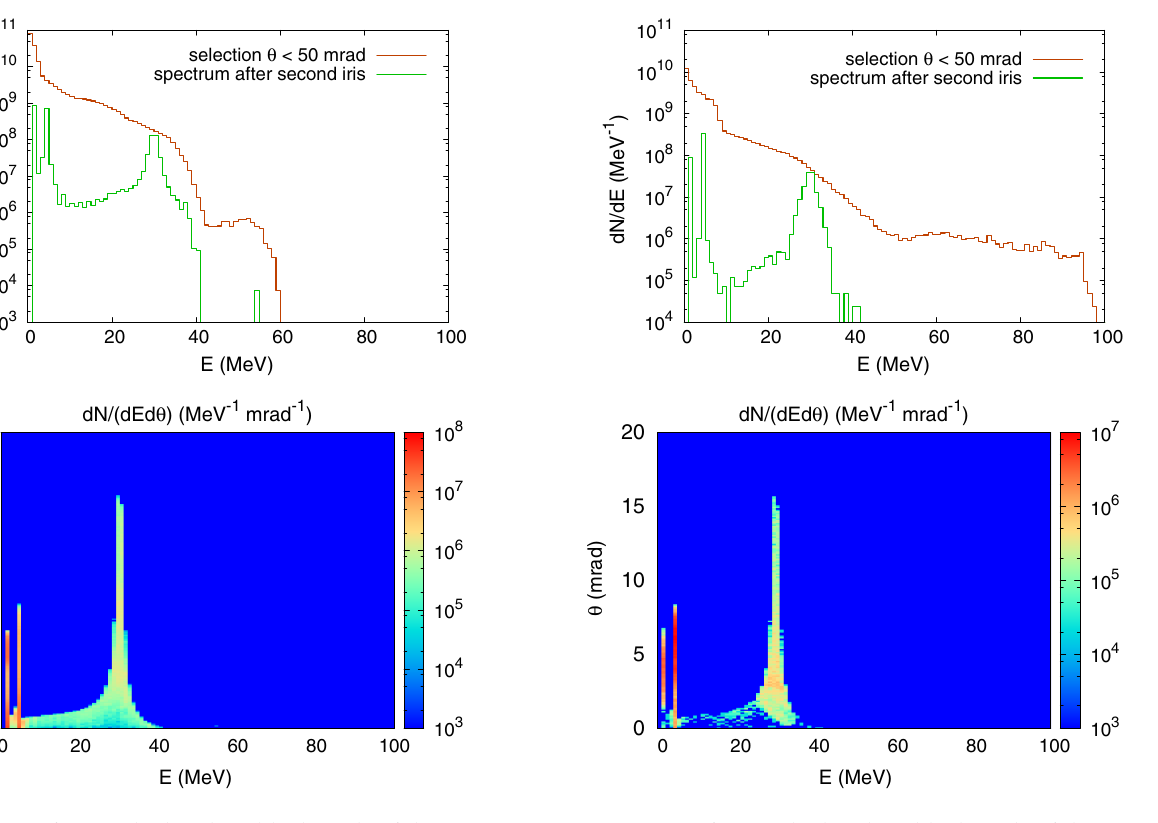
FIG. 7. Upper frame: Plot in a logarithmic scale of the proton energy spectrum after the second collimator (dark green curve) for the composite target foam þ foil (TNSA) compared with the spectrum after the first collimator which selects the angle to (cid:7) < 50 mrad (light brown curve). Lower frame: Plot of the energy- angle distribution of the bunch after the second collimator in a logarithmic color scale.